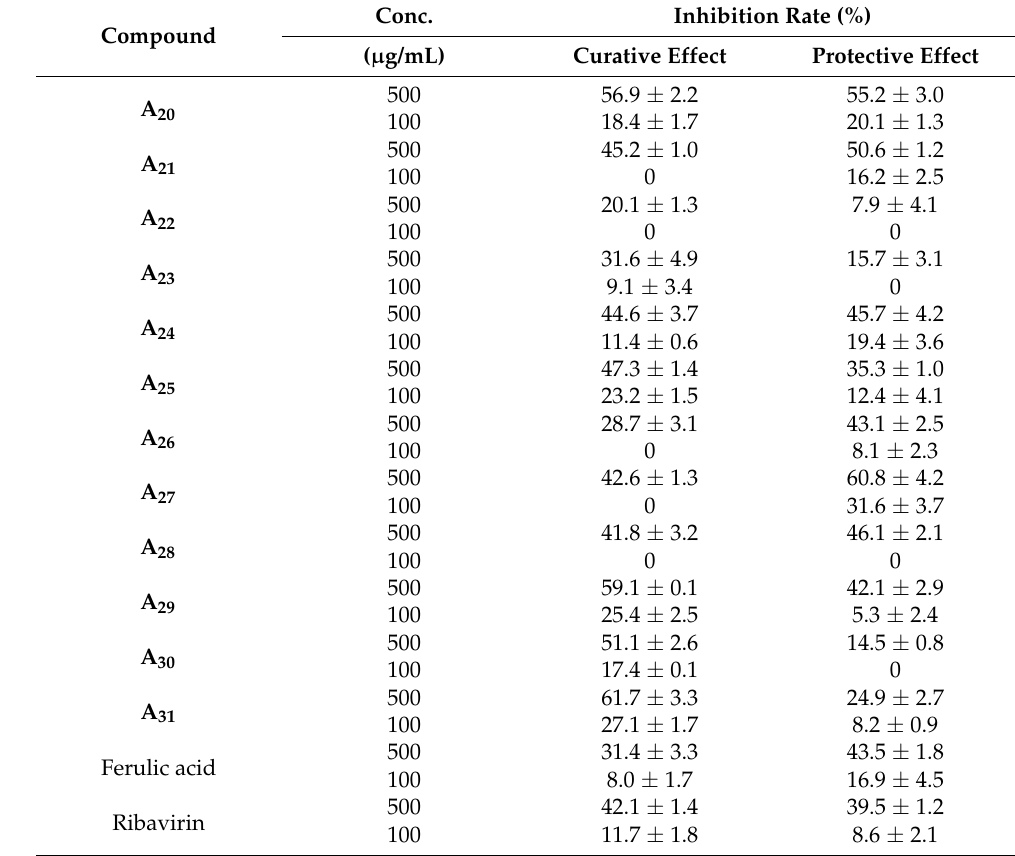
Figure 3. Synthetic routes for the target molecules A 20 ‐ A 31 . Table 2. The in vivo anti-TMV activity of synthesized compounds ( A 20 – A 31